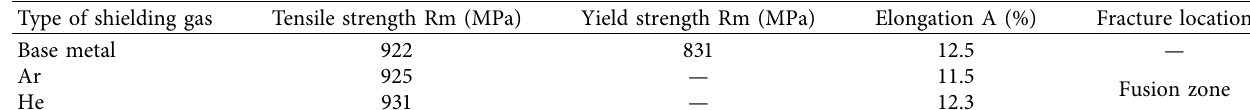
Table 4: Results of tensile strength.